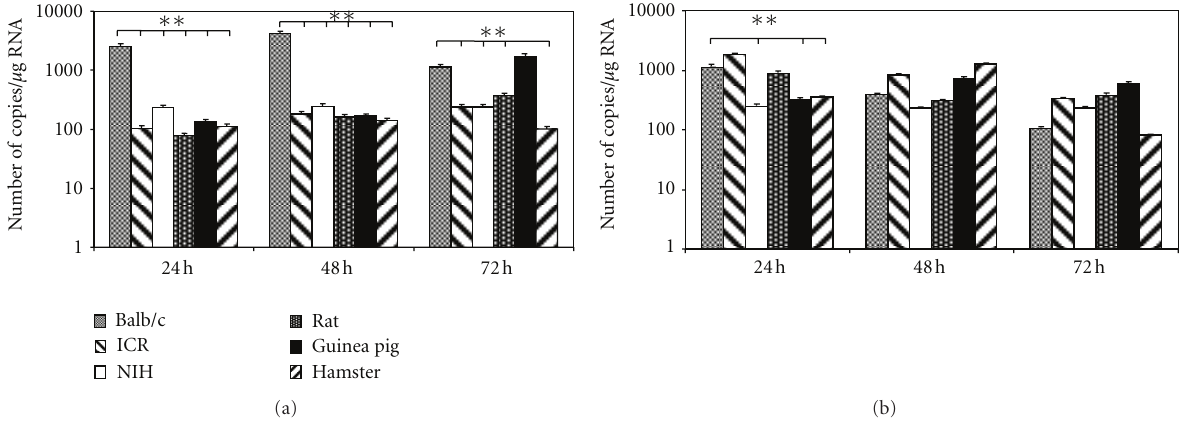
Figure 1: qRT-PCR to obtain absolute quantification of viral copies yielded to supernatants from di ff erent rodent species’ peritoneal macrophages cultures. (a) Cells infected at a MOI 0,1 and (b) MOI 1. ∗∗ P < 0 .